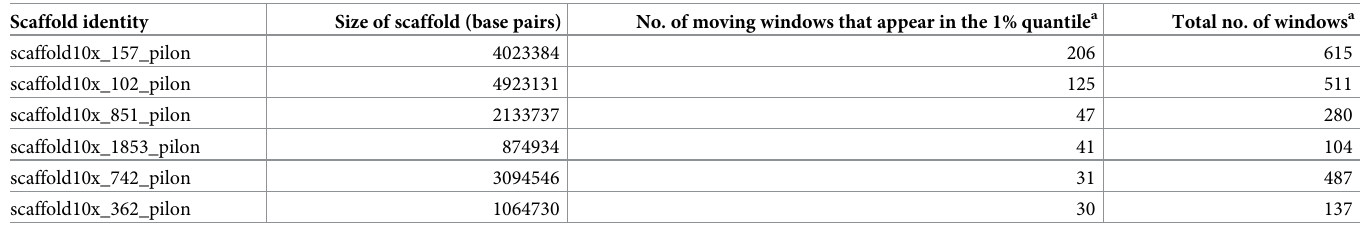
Table 3. Scaffolds showing evidence of selection in Field Isolate 1. Scaffold